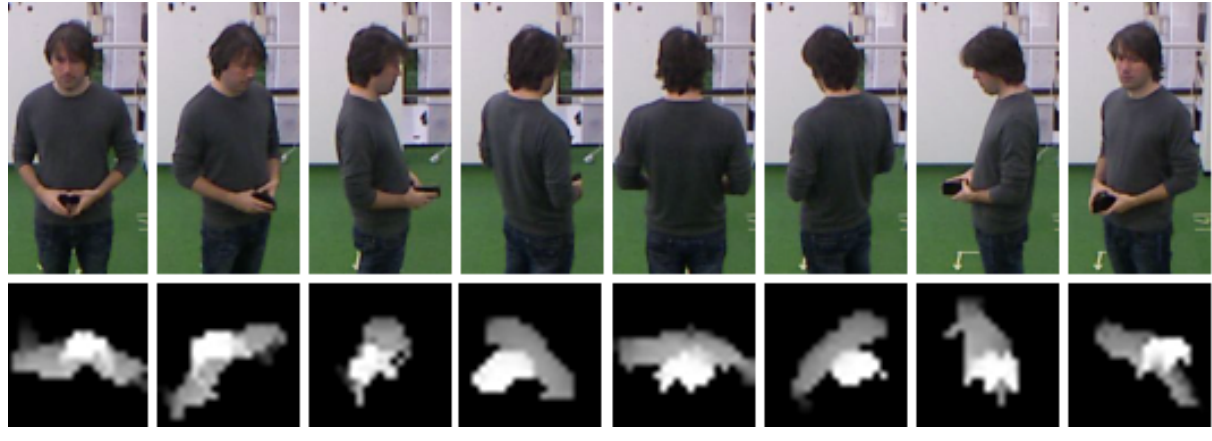
Figure 6. The top row shows eight headings for one person at the same position in reference to the camera. The bottom row contains examples of related height templates used in orientation classification with neural